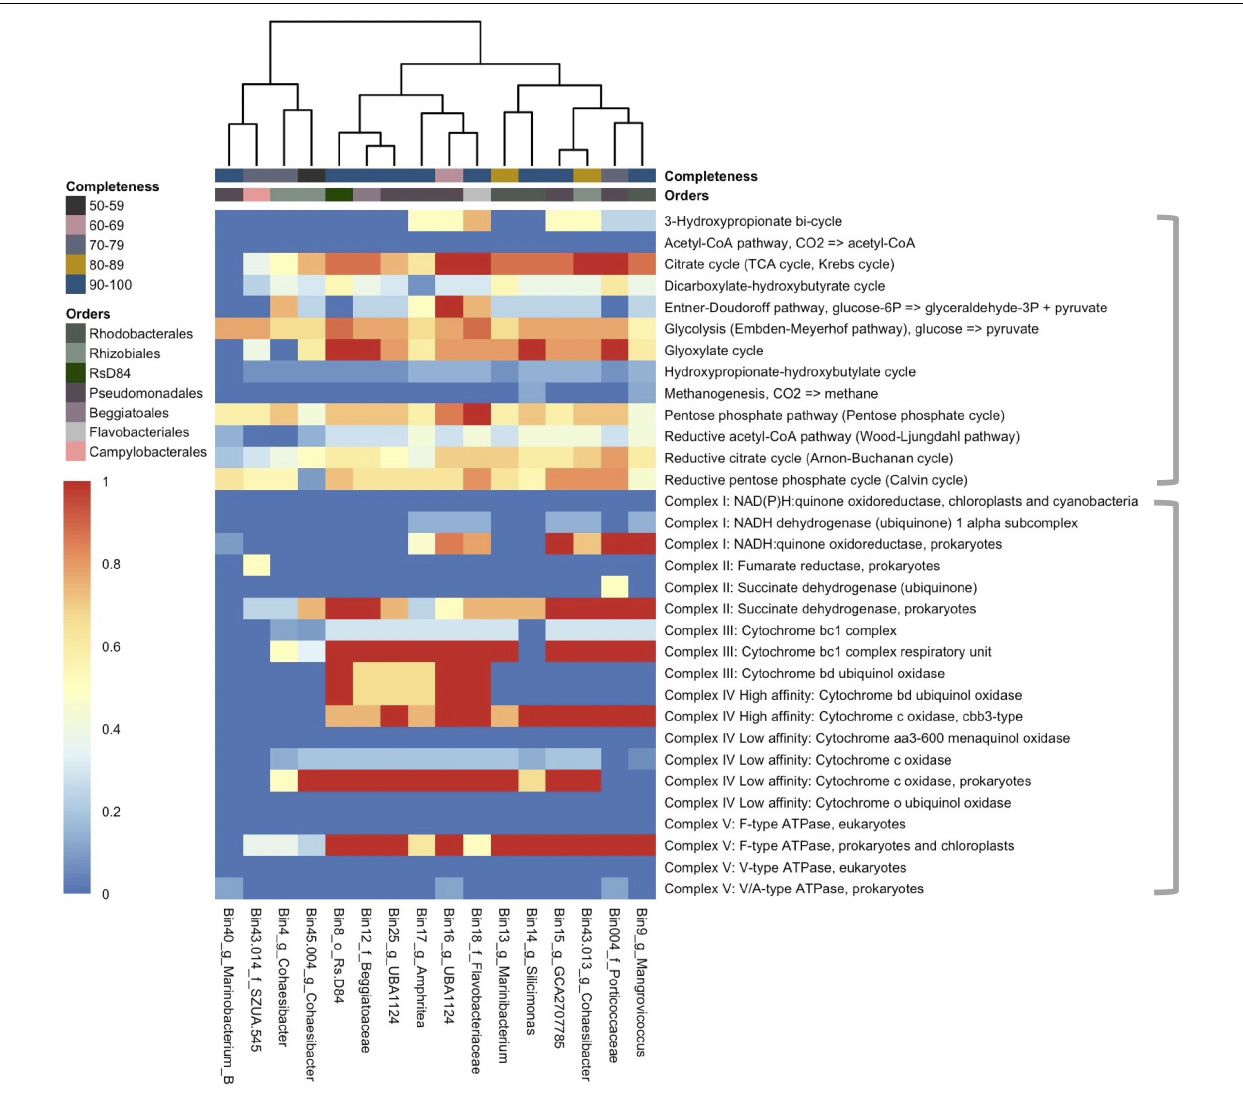
Figure 3 ). With a minimum alignment fraction of 0.65,